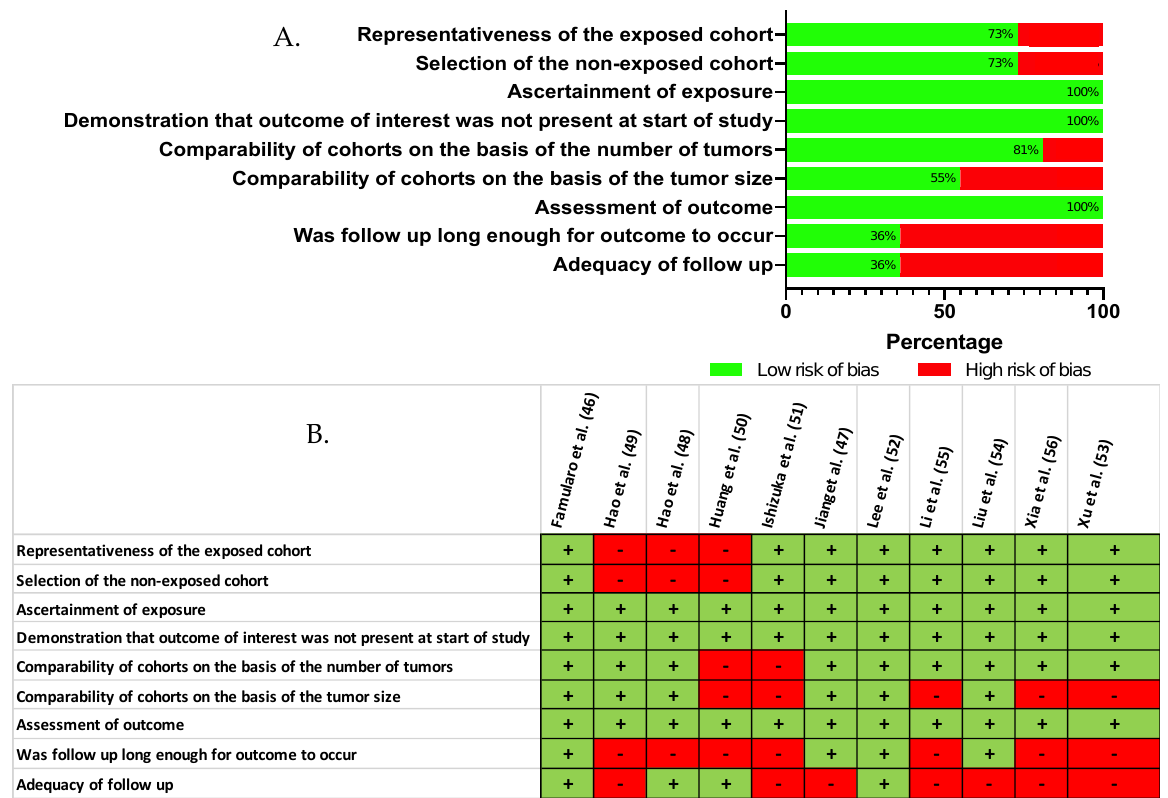
Figure 3. Critical appraisal of the reviewed literature, according to the Newcastle Ottawa Scale ( A ) Reviewer’s judgment about the risk of bias item presented as percentages across all included studies (NOS) ( B ) Risk of bias as estimated by the authors for each item and each study that was included [46,47,48,49,50,51,52,53,54,55,56] .